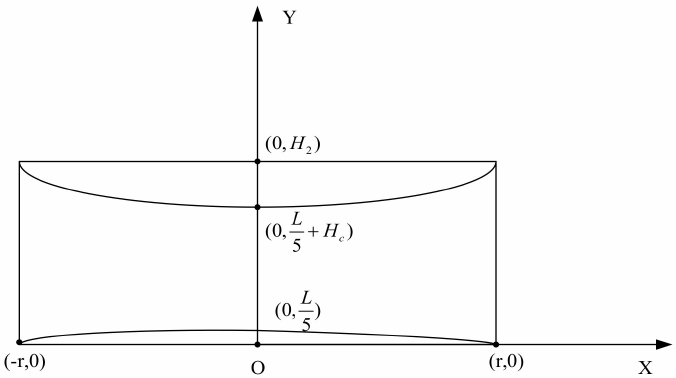
Figure 3. Asymmetric paraboloid-shaped net